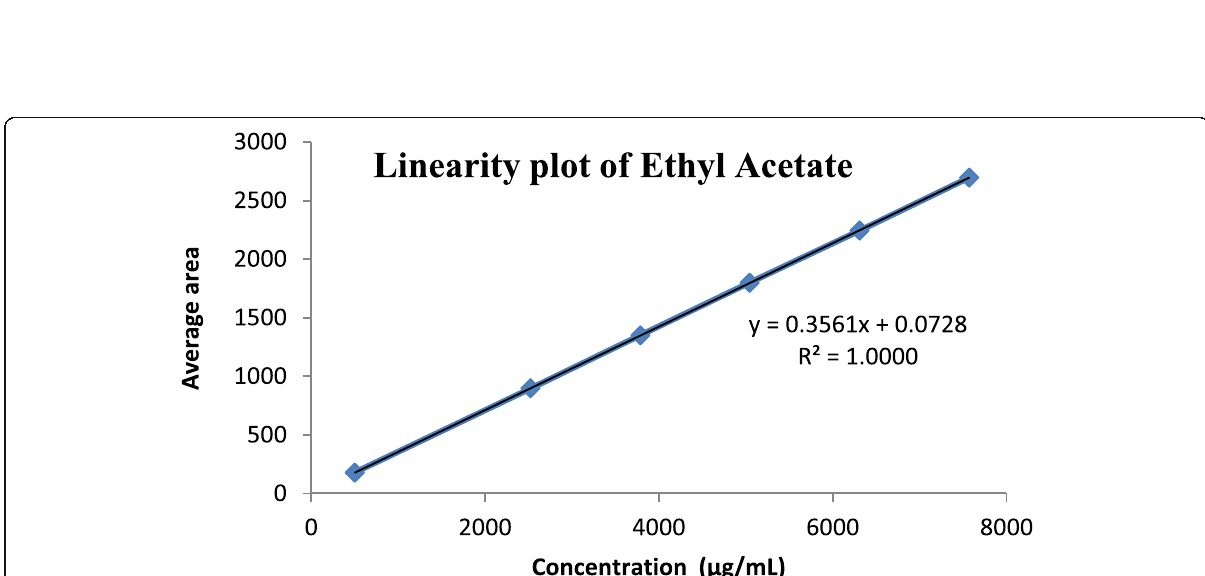
Fig. 10 Linearity plot of